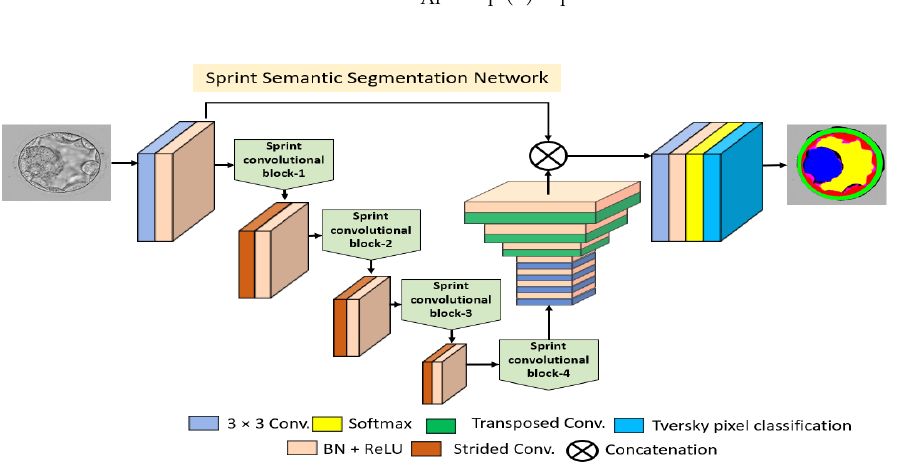
Figure 4. The architecture of proposed SSS-Net. 3 × 3 Conv. and Transposed Conv. represent convolution layers with 3 × 3 kernel and transposed convolution, respectively. In addition, BN, ReLU, and Strided Conv. represent batch normalization, rectified linear unit, and strided convolution, respectively.